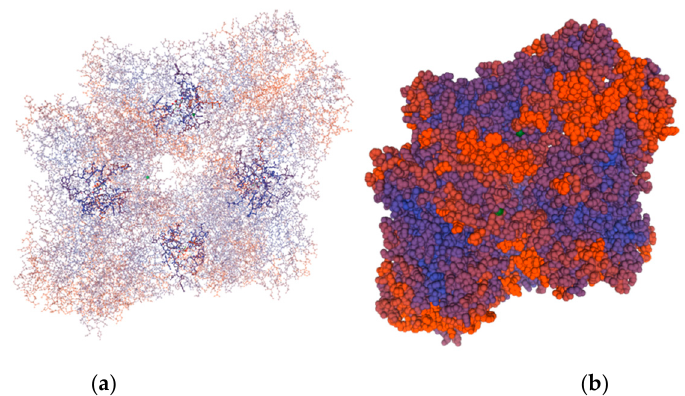
Figure 2. Three-dimensional model of β -galactosidase of L. bulgaricus strain 43 made by SWISS- MODEL Workspace [29]. ( a ) “Ball and stick” presentation of the chains revealing the formation of four active centers around the substrate; ( b ) surface model of the tetramer.